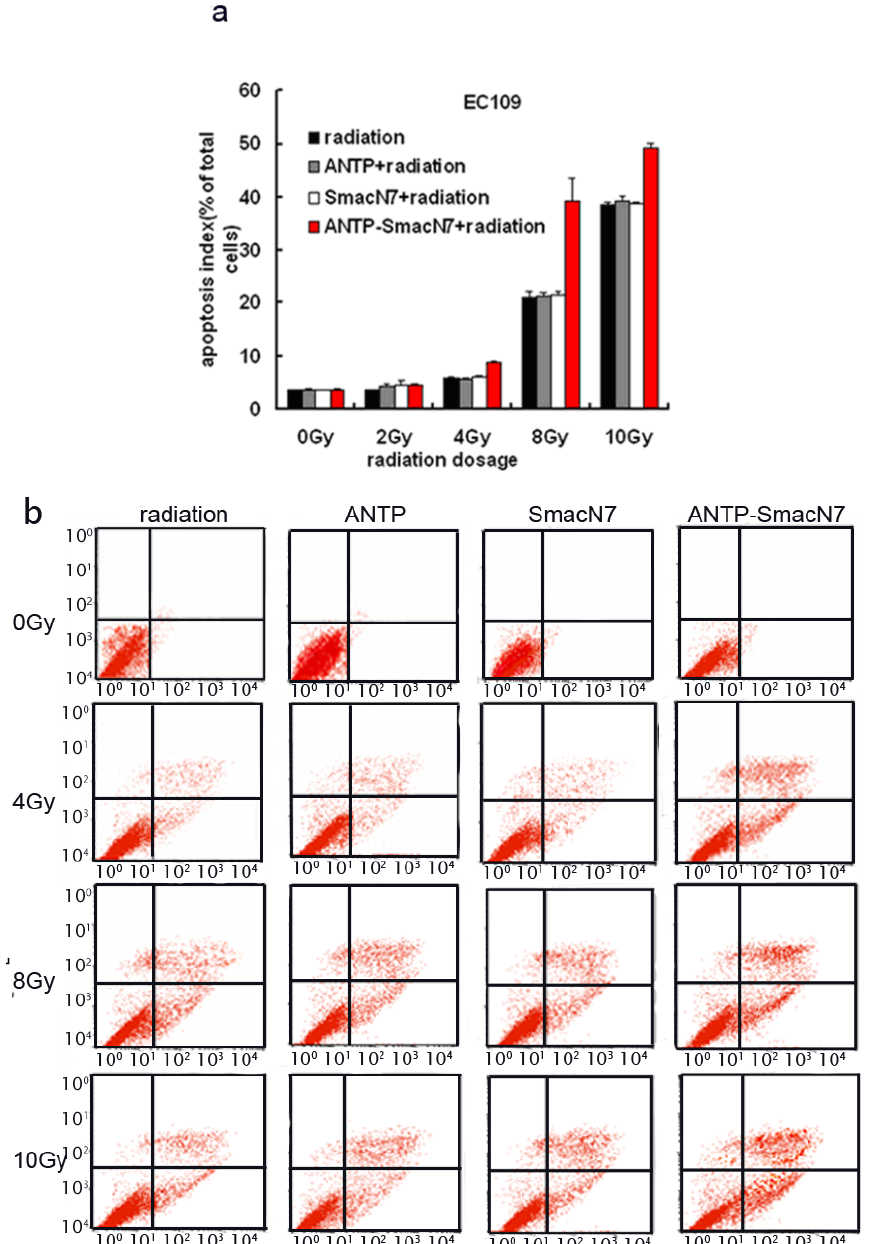
Figure 4. Effects of ANTP-SmacN7 on radiation-induced apoptosis ( a ). The apoptotic index of EC109 cells after treatment with ANTP, SmacN7, and ANTP-SmacN7 combined with radiation; and ( b ) Graph of the flow cytometry